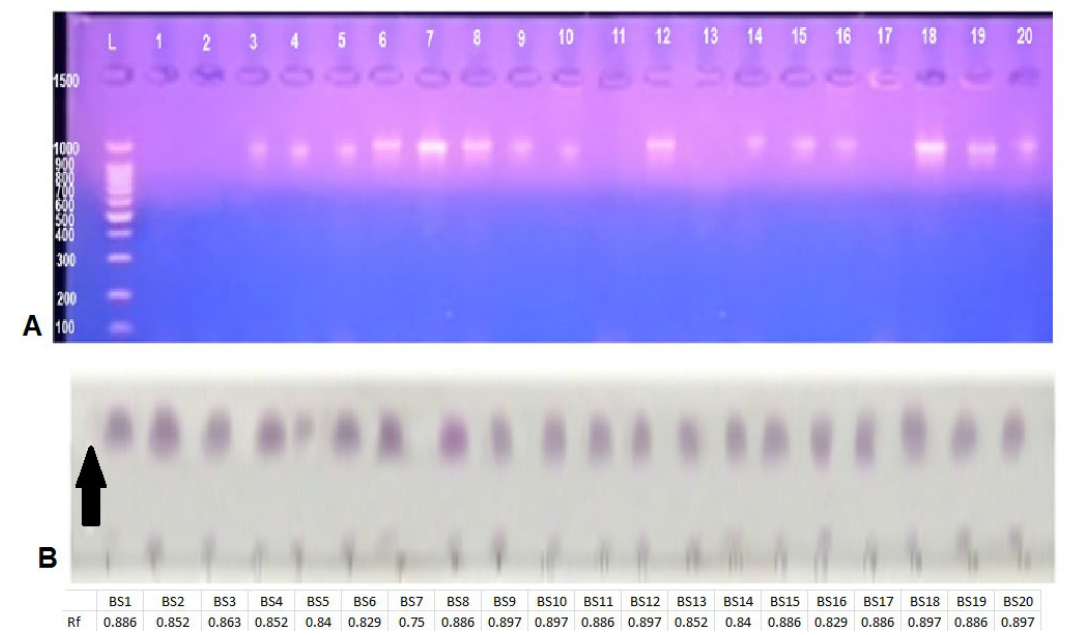
Figure 1. (A) Gel electrophoresis for the gene “ gyrA ” PCR amplification of bacterial isolates DNA B. subtilis , B. amyloliquefaciens Positive amplifications of single (1025 bp) bands are noticed for isolates while negative (B) Rf results of TLC for secondary metabolites extracts of Bacillus spp. results without amplifications belong to isolates, in comparis on to L: 1kb DNA ladd er The samples numbered 1-20 represe nt the 20 differe nt bacteria l isolates. 3.3. Secondary metabolites extracts inspection and